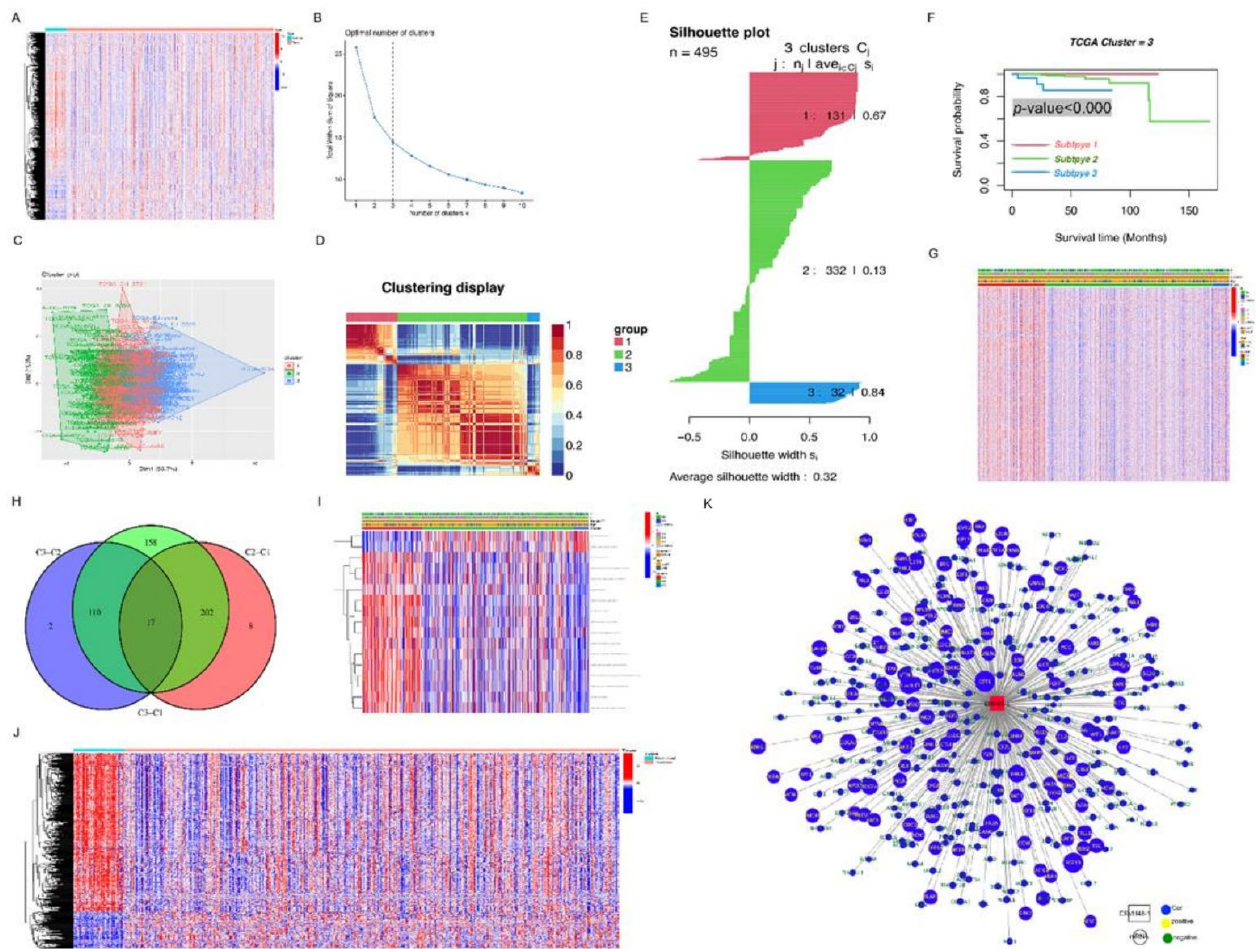
Figure 2. PCa subgroups identified to have clinical relevance. ( A ) GSVA computed the enrichment score (ES) heat map for 4922 gene sets; ( B ) the optimal number of clusters (K) was determined using the factoextra package; ( C ) cluster results were visualized using the factoextra package; and ( D ) PCa samples were clustered using the nonnegative matrix factorization (NMF) method. The CancerSub ‐ types tool was used to generate silhouette width plots. ( E ) The CancerSubtypes tool was used to generate silhouette width plots. ( F ) Survival patterns were analyzed using the CancerSubtypes pro ‐ gram; ( G ) a link was revealed between their expression and other clinical variables; and ( H ) the differential enrichment score of gene sets was computed between each grouping and